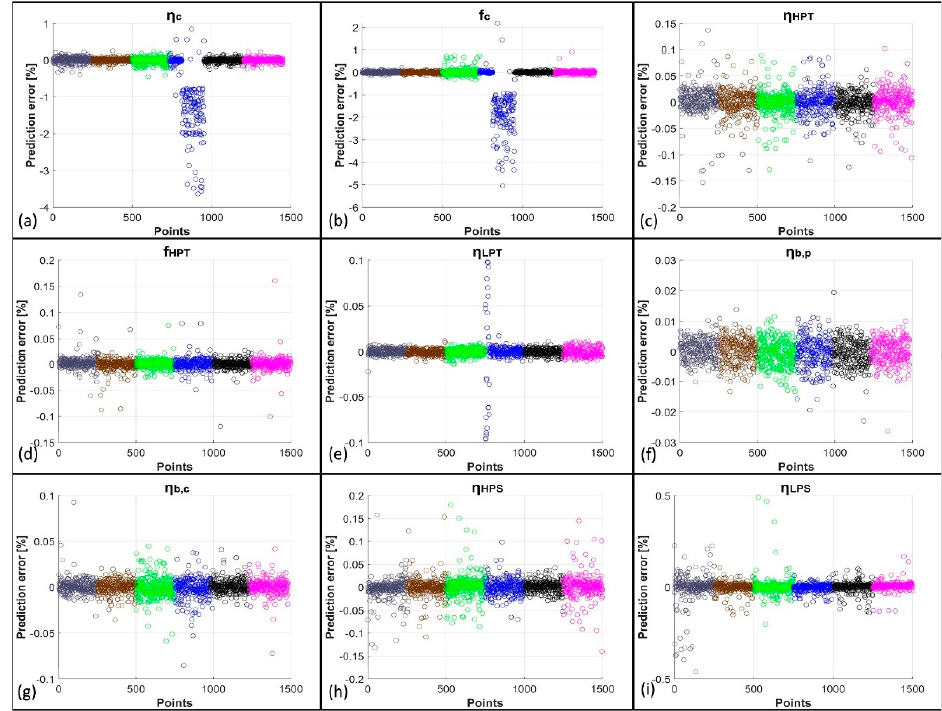
Figure 6. ( a – i ) Percentage errors between KPCA + FFNN predictions and targets about the PPs related to the first five degradation conditions. Grey: START-A; brown: START-B; green: MAXPOW- A; blue: MAXPOW-B; black: MAXDUR-A; magenta: MAXDUR-B.